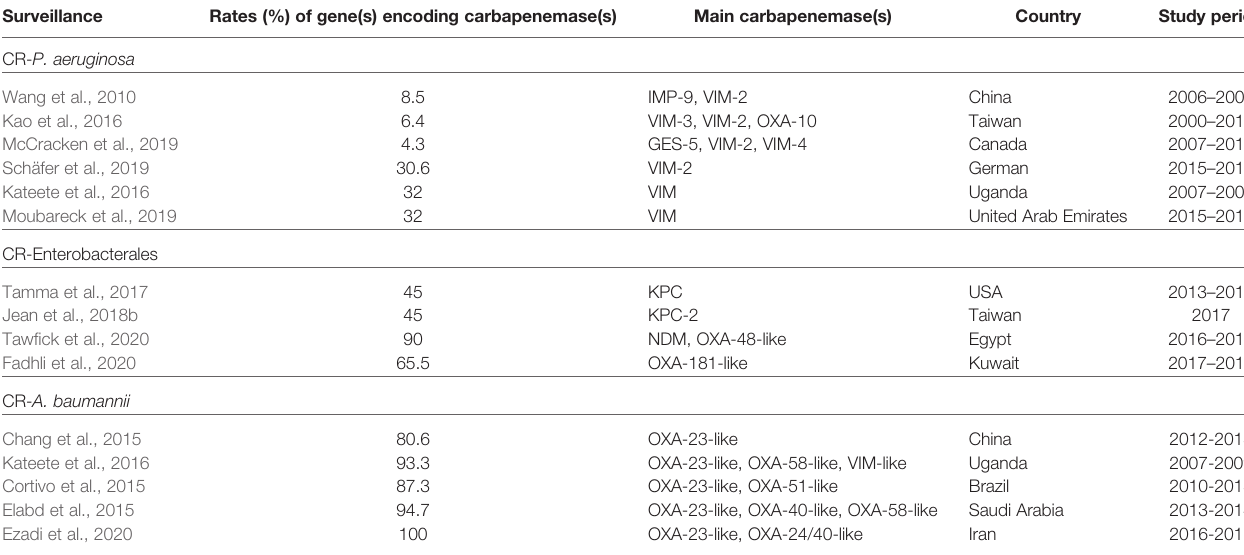
TABLE 1 | Rates of gene(s) encoding carbapenemases among isolates of carbapenem-resistant (CR) Enterobacterales, CR- Pseudomonas aeruginosa and CR- Acinetobacter baumannii complex in different surveillances. Surveillance Rates (%) of gene(s) encoding carbapenemase(s)